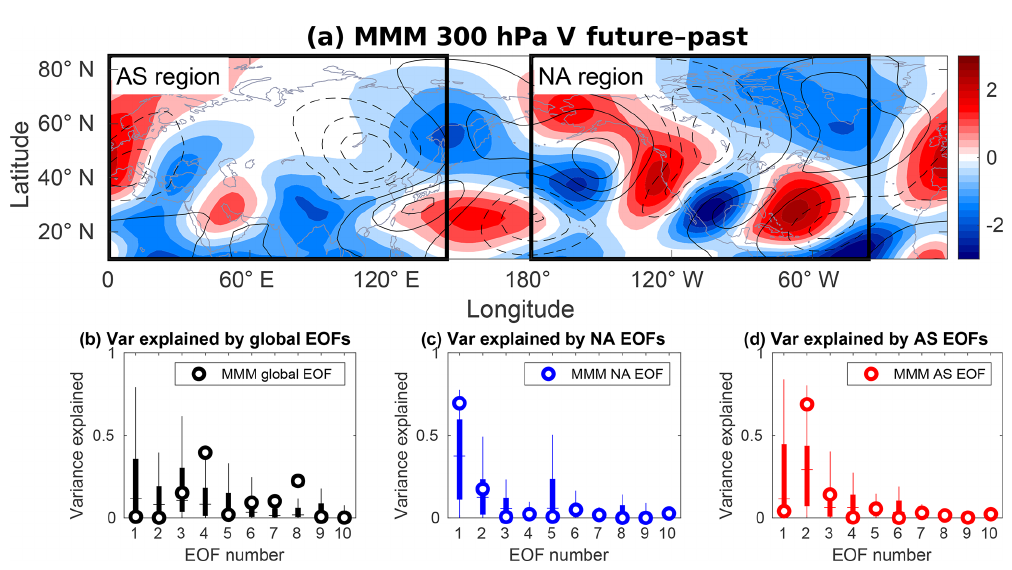
Figure 4. (a) Multi-model mean 300hPa DJF meridional wind. Contours show past (1979–2005) climatology, and shading denotes the anomaly between the future period (2070–2099) and past period; boxed regions are the domains used for regional EOF calculations and projections hereafter (AS – Eurasia; NA – Pacific North America). The contour interval is 3ms − 1 and the zero contour is omitted; (b– d) percentage of spatial variance of every model’s anomaly (similar to the shading in a ), as explained by its leading 10 global (b) and regional (c, d) EOFs. Horizontal lines are the ensemble median, bold vertical bars cover the interquartile range, and thin bars mark the top and bottom quartiles. White circles denote the results for the same calculation, performed with the MMM EOFs and